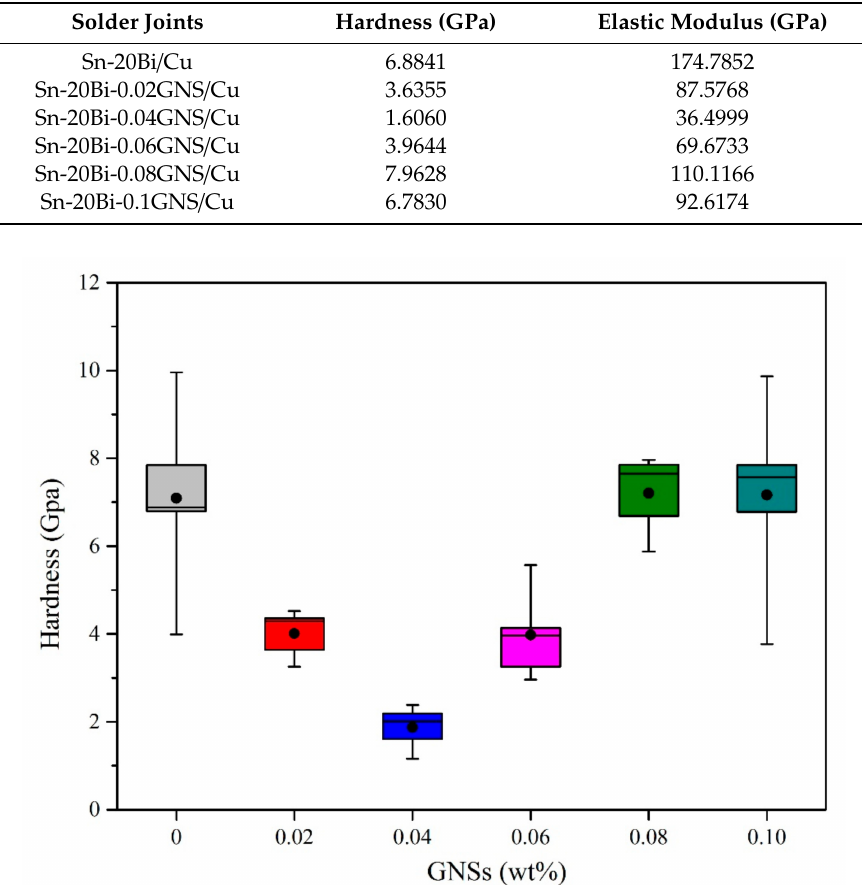
Figure 8. Hardness of IMCs at solder / Cu interface with various GNS